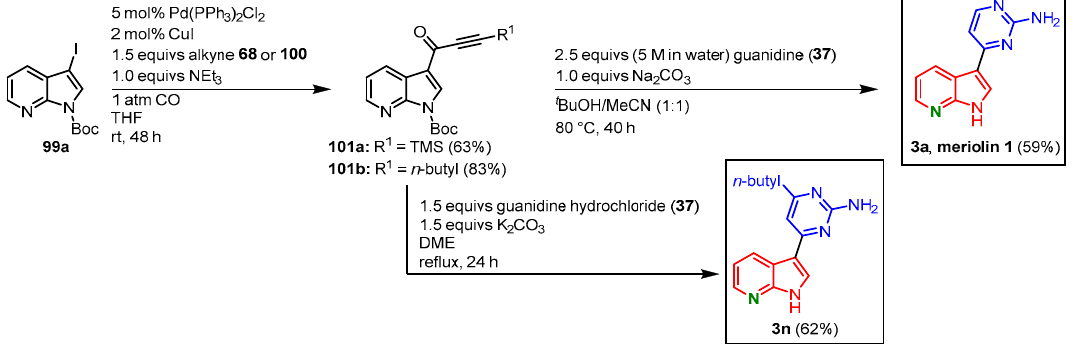
Figure 26. Synthesis of meriolins 3a and 3n via carbonylative alkynylation and subsequent pyrimidine synthesis by Müller [61,68]. synthesis by Müller